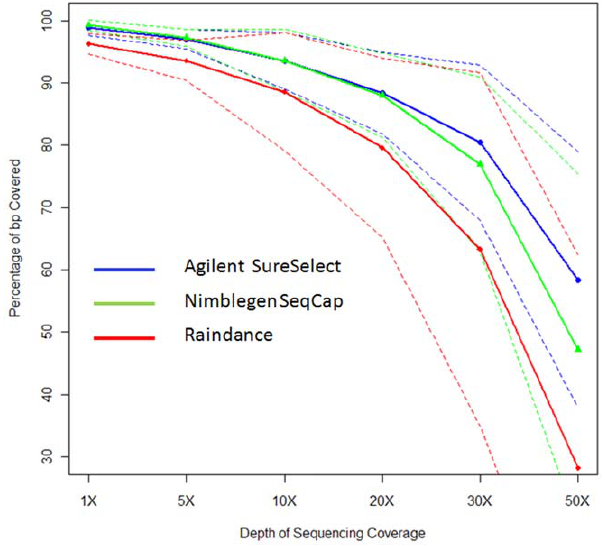
Figure 2. Depth of sequencing coverage of matched sample set (N=6 samples (per method)). Percent of on-target bases (y-axis) covered at a given sequence depth (x-axis). On target percentage calculated as the fraction of nucleotide bases falling on targeted regions divided by the total number of nucleotides mapping anywhere in the genome. Thick lines represent average coverage for each platform (Agilent Surelect=blue circles; Nimblegen SeqCap=green triangles; Raindance parallel PCR= red diamonds). Dashed lines represent two standard deviations above and below the average for each